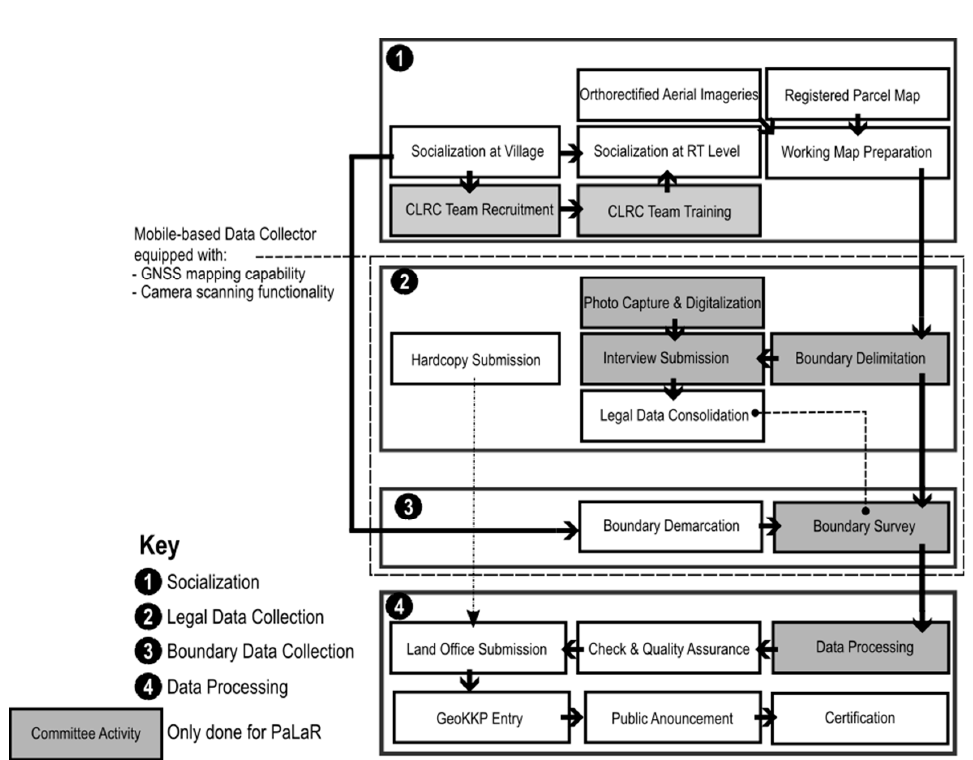
Figure 1. Workflow of PTSL and PaLaR activities (grey boxes were applied for PaLaR only, not for